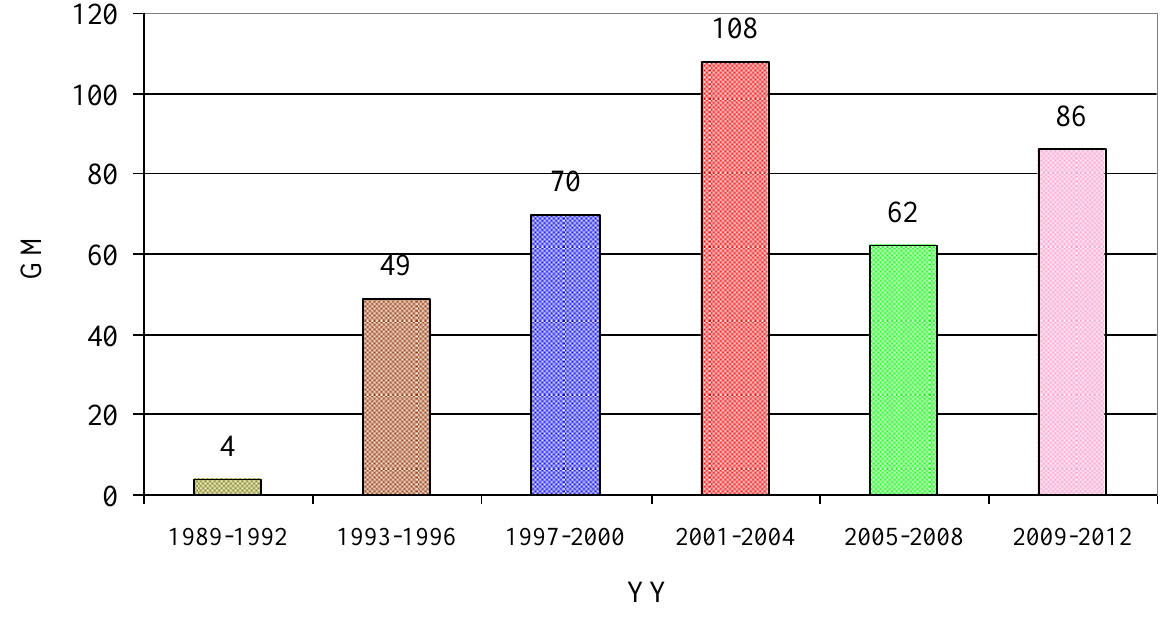
Fig. 1. Distribution of gold medals (GM) won by Ukrainian athletes at World and European Powerlifting Championships in different periods